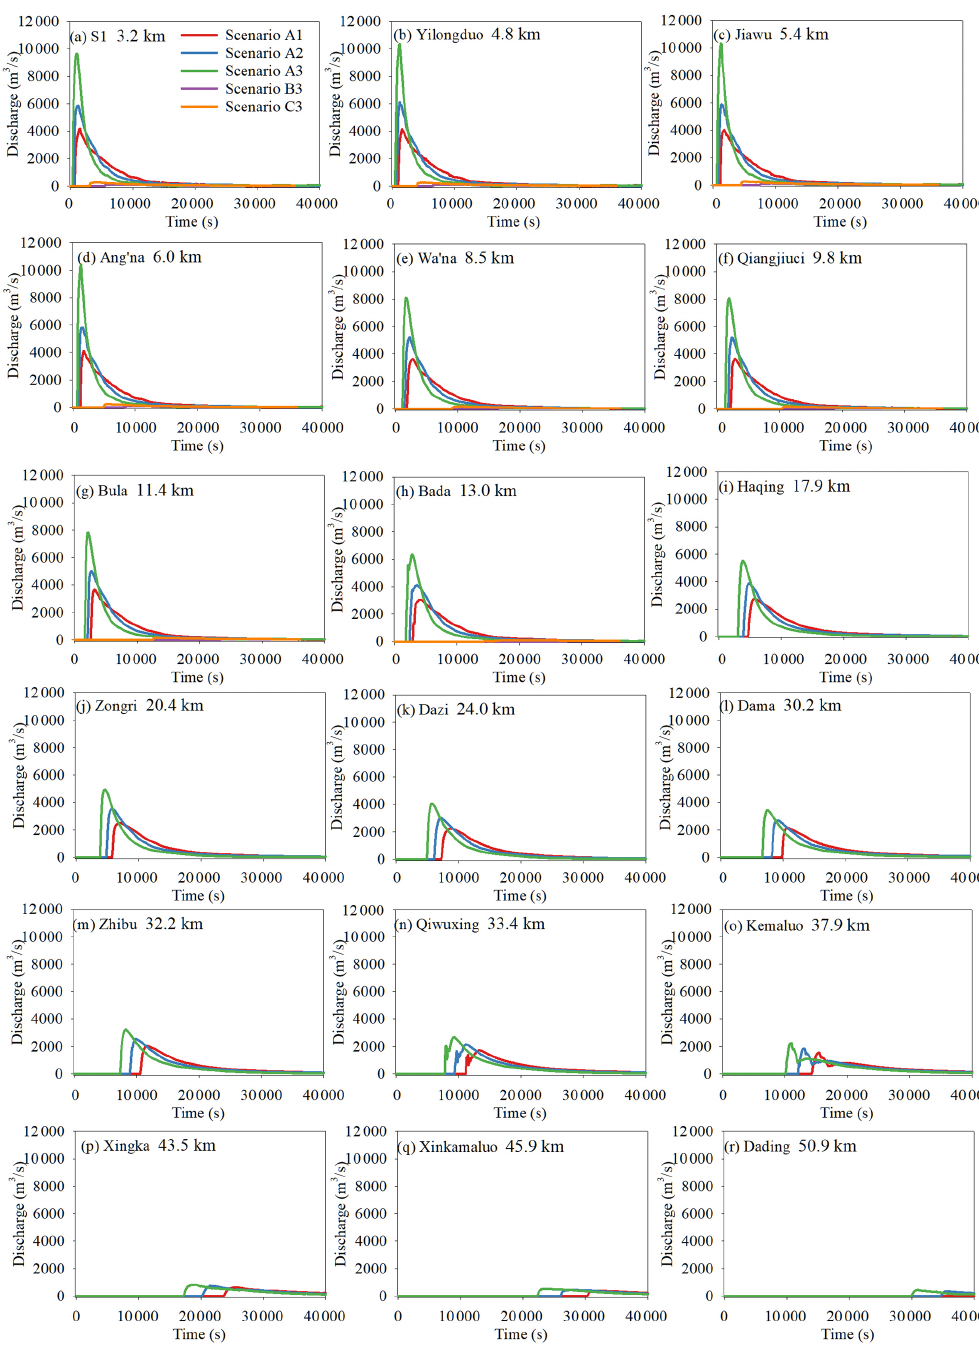
Figure 13. Time series of discharge at different settlements along the flow channel (locations in Fig. 1) of different